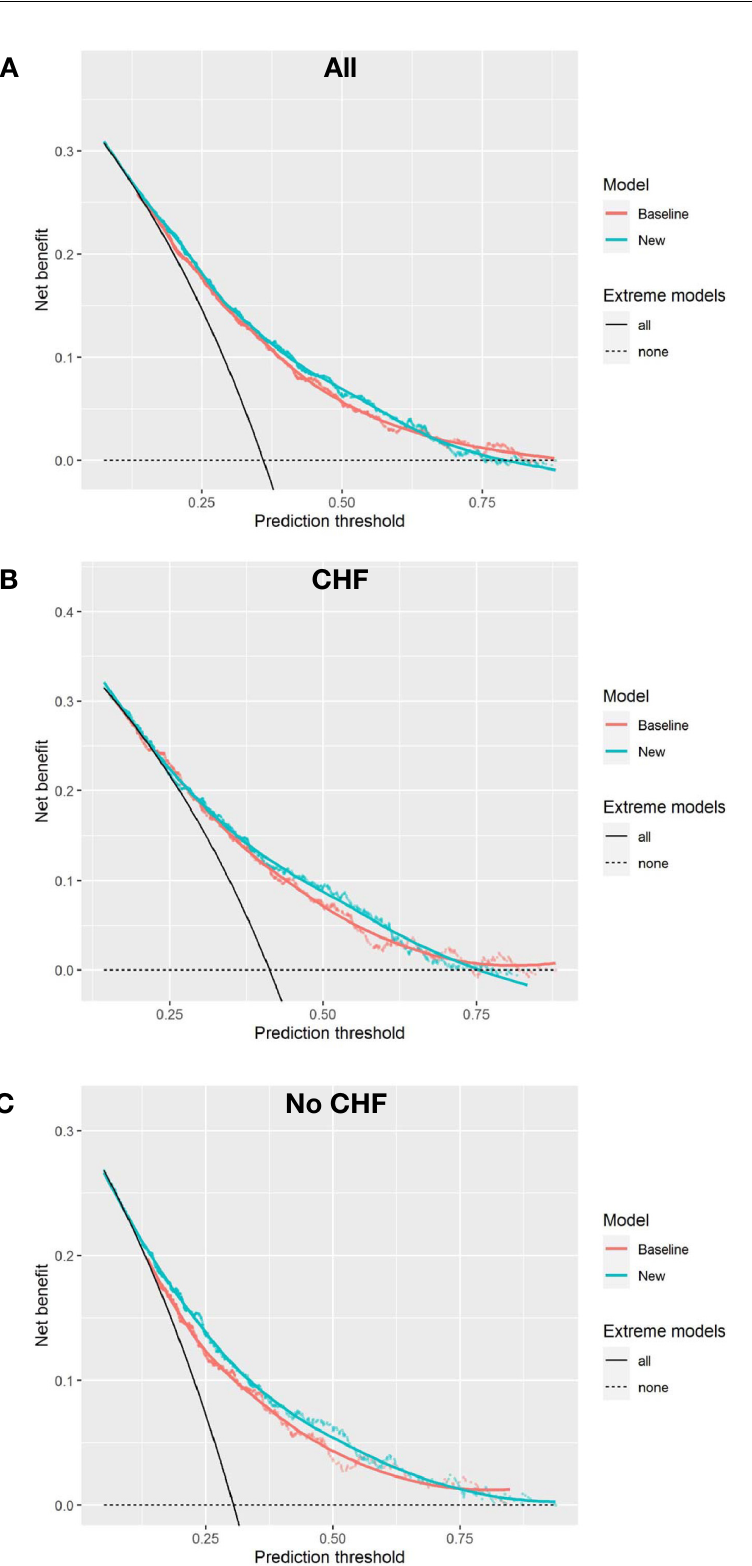
Fig 4. Decision curves. At specific prediction of mortality thresholds the new model (teal curve) with the addition of BNP has higher net benefit to the baseline model (red curve). All patients included in panel A, with separate models for Congestive Heart Failure participants in panel B, and non-Congestive Heart Failure participants in panel C.